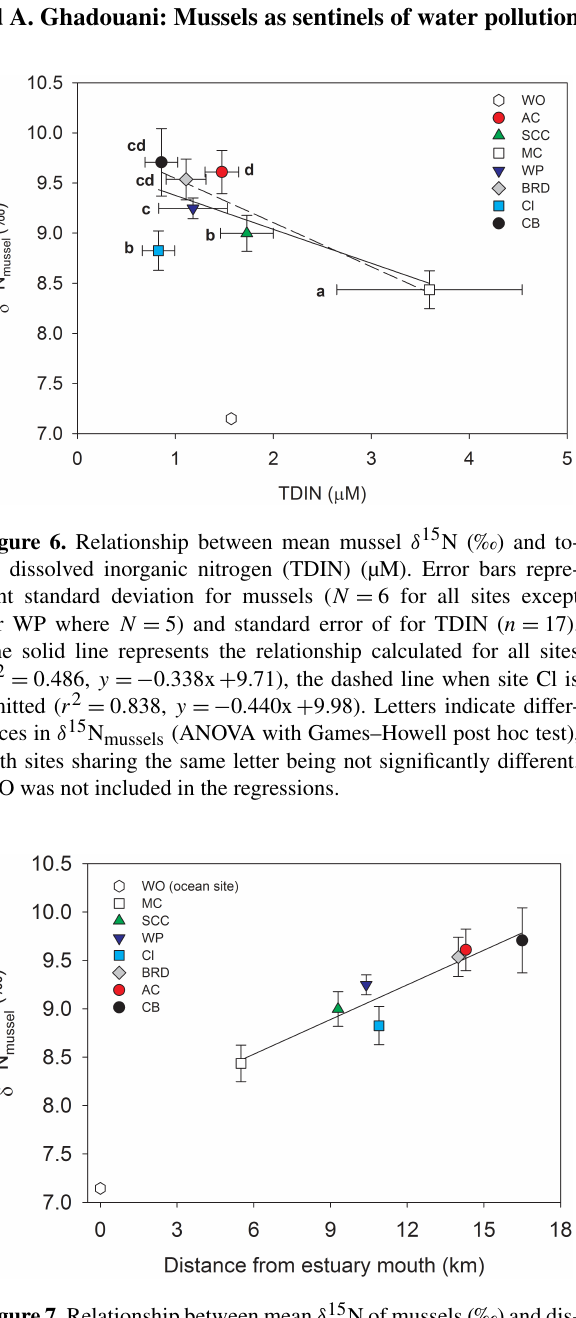
Figure 7. Relationship between mean δ 15 N of mussels (‰) and dis- tance of sites from estuary mouth ( r 2 = 0 . 563, y = 0.12x + 7.74). Error bars represent standard deviation of N = 6 for all sites except for WP where N =